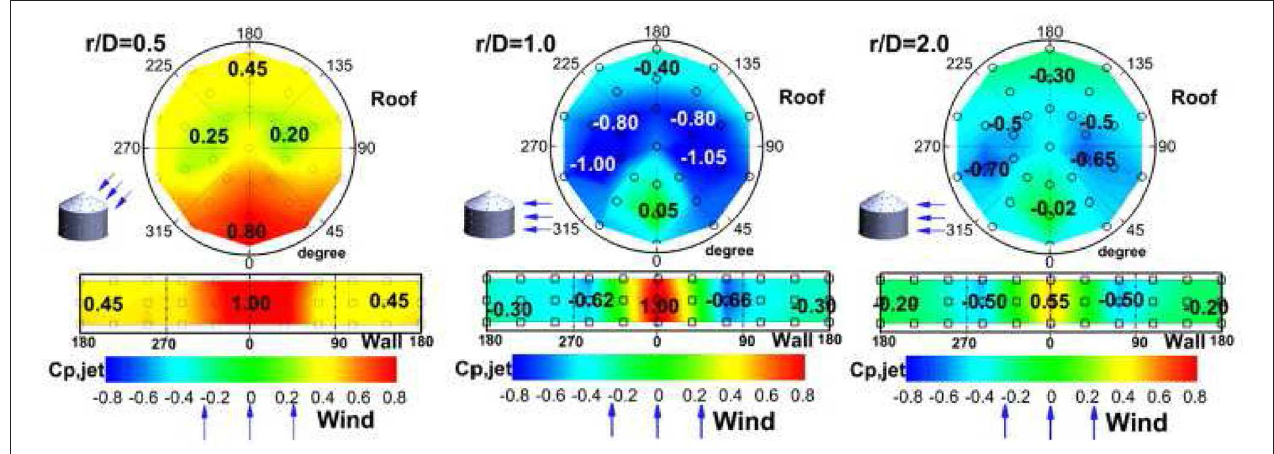
FIGURE 7 | Mean pressure coefficients for a grain bin model. Reproduced from Zhang et al. (2014a) with permission from Elsevier.